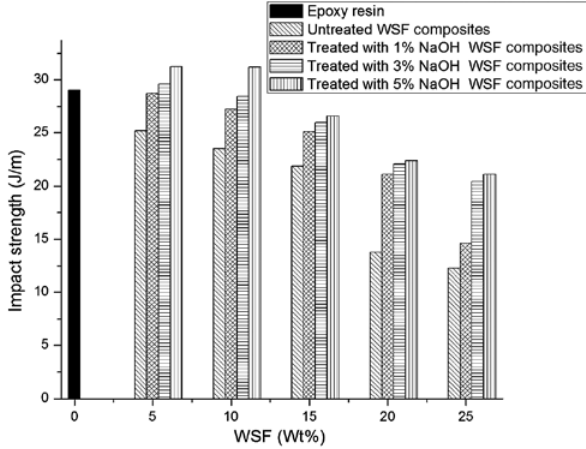
Figure 5: Effect of fiber content and alkali treatment on the impact strength of WSF-epoxy composites.